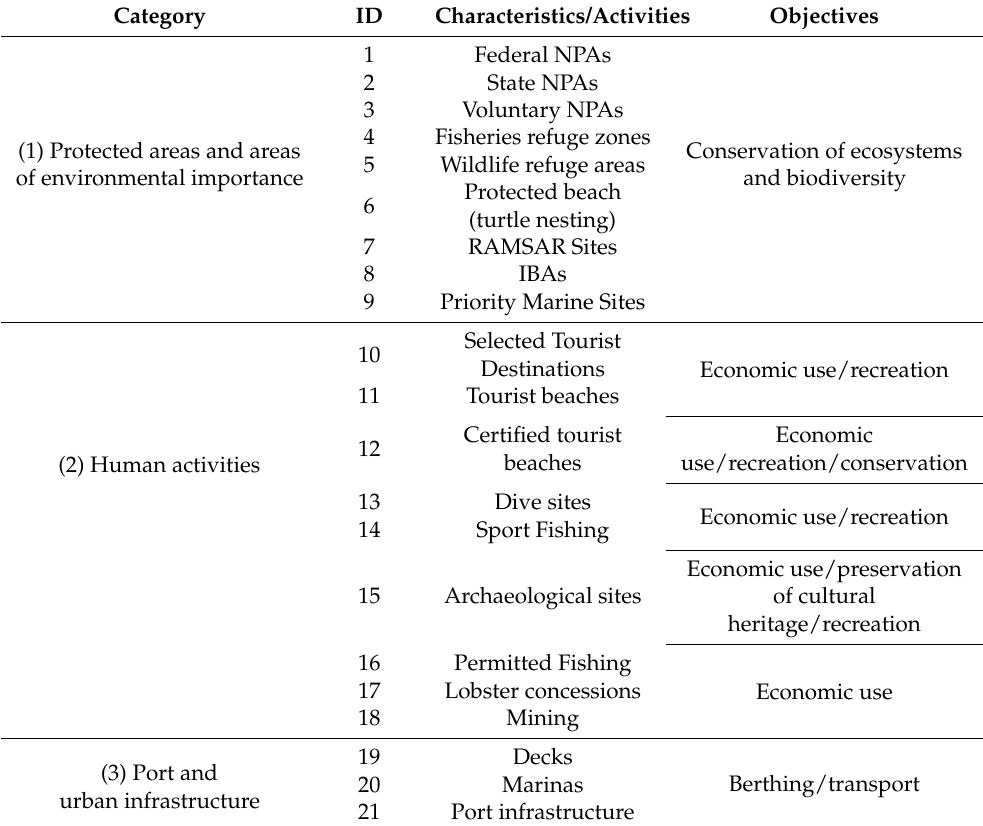
Table 1. Characteristics/activities assessed for compatibility in the Caribbean